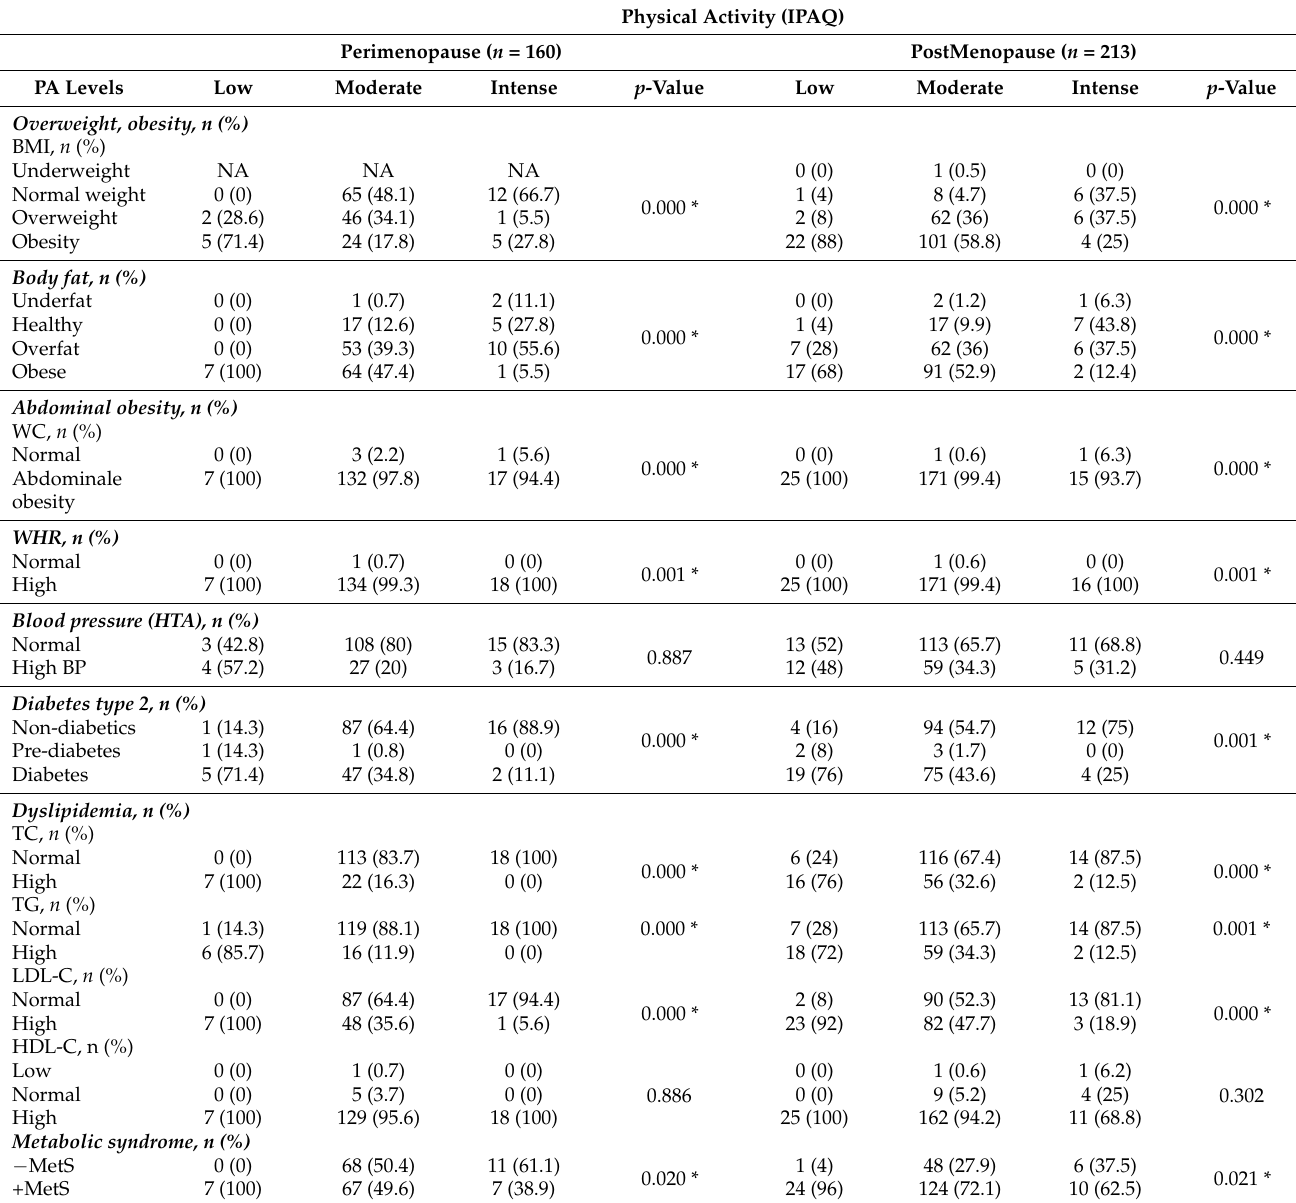
Perimenopausal women with moderate and intense PA levels had lower frequencies of hypertension (20%), diabetes (34.8%), and MetS (49.6%) than postmenopausal women (hypertension (34.3%), diabetes (43.6%), and MetS (72.1%)). In postmenopausal participants with a low PA level, the frequencies of elevated serum lipid concentrations (TC, TG, LDL-C) were lower than in perimenopausal participants; conversely, they were higher in postmenopausal participants than in perimenopausal participants with moderate and intense PA levels. There was a statistically significant difference between PA levels and the number of MetS components ( p < 0.002); indeed, the percentages of women who had 4 or 5 MetS components were lower at moderate and intense PA levels, respectively (Table 3). Table 3. Frequency of metabolic disorders in peri- and postmenopausal participants according to physical activity level. Physical Activity